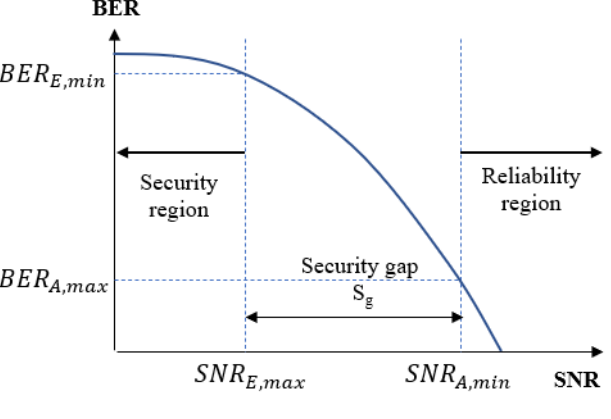
Figure 3. Security